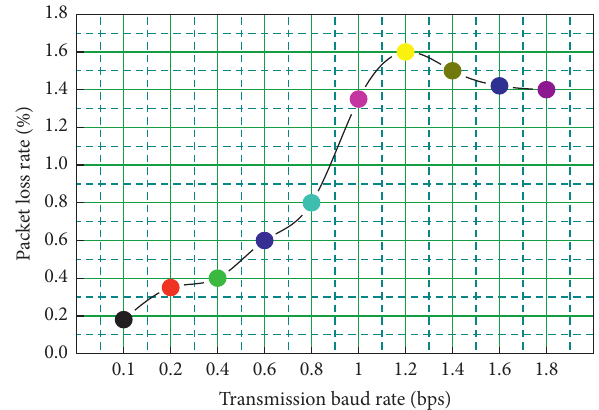
Figure 6: Personnel information